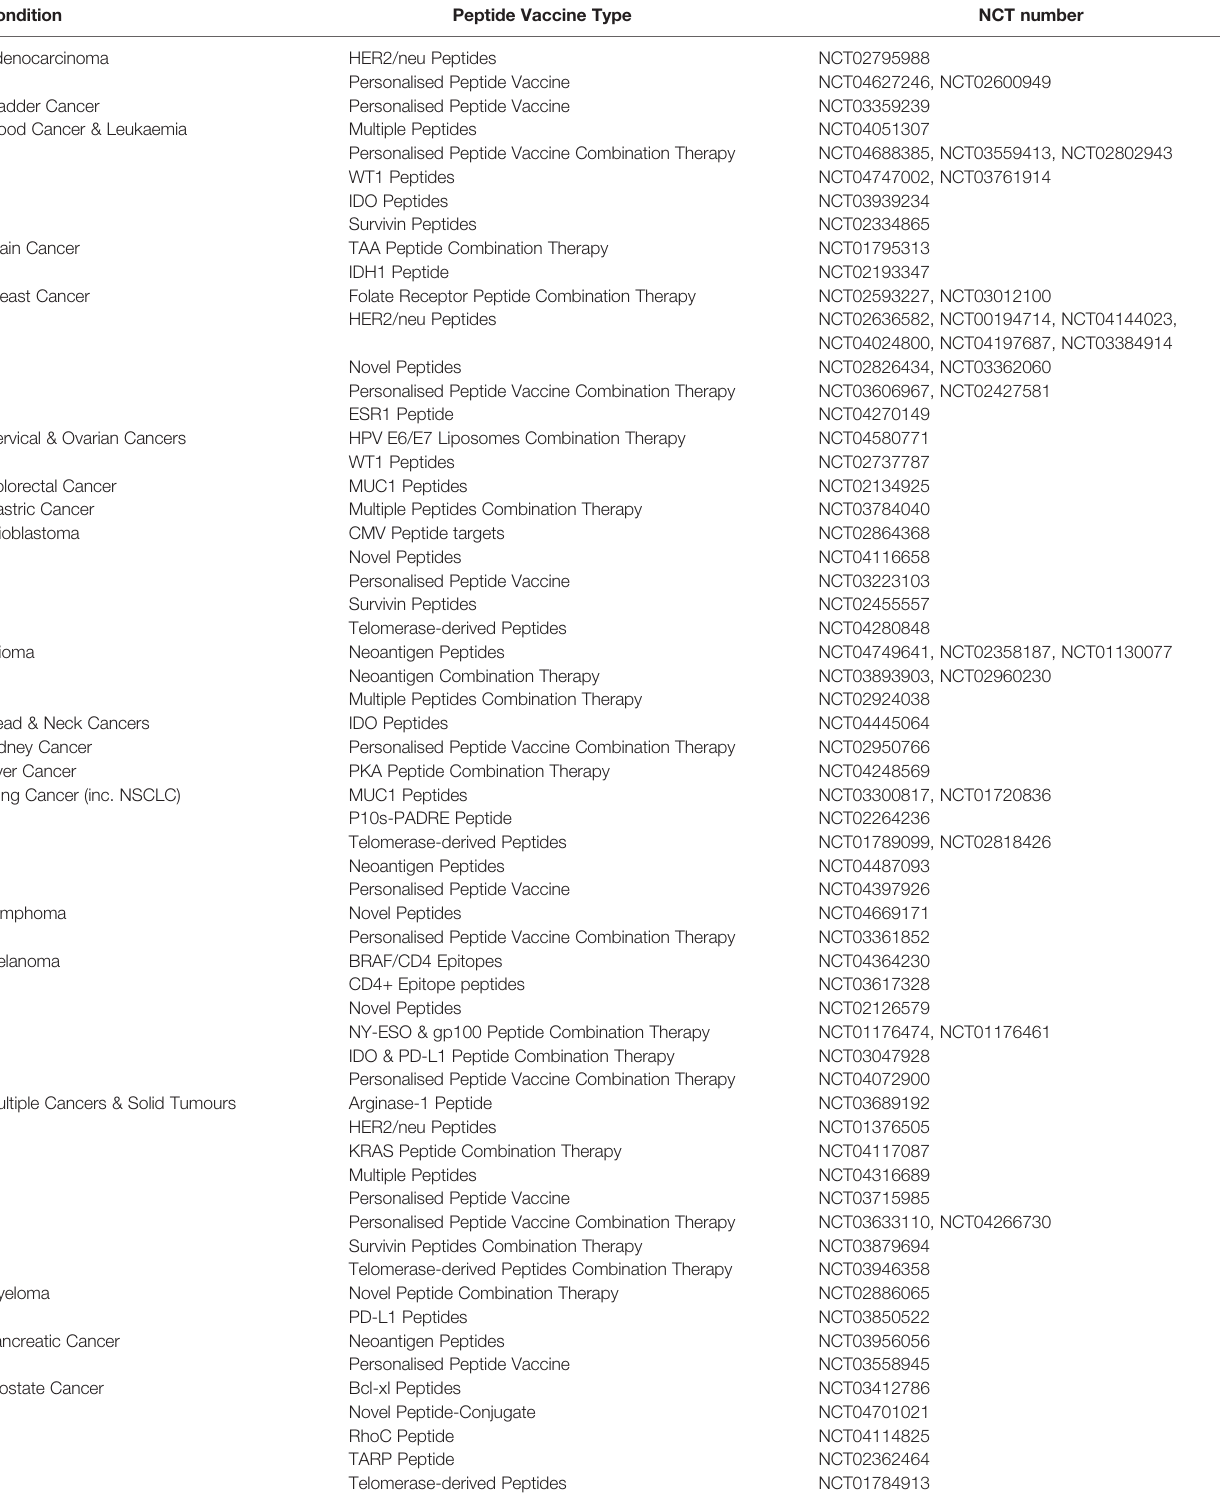
TABLE 1 | A summary of Phase I and II peptide-based cancer vaccine clinical trials currently active or